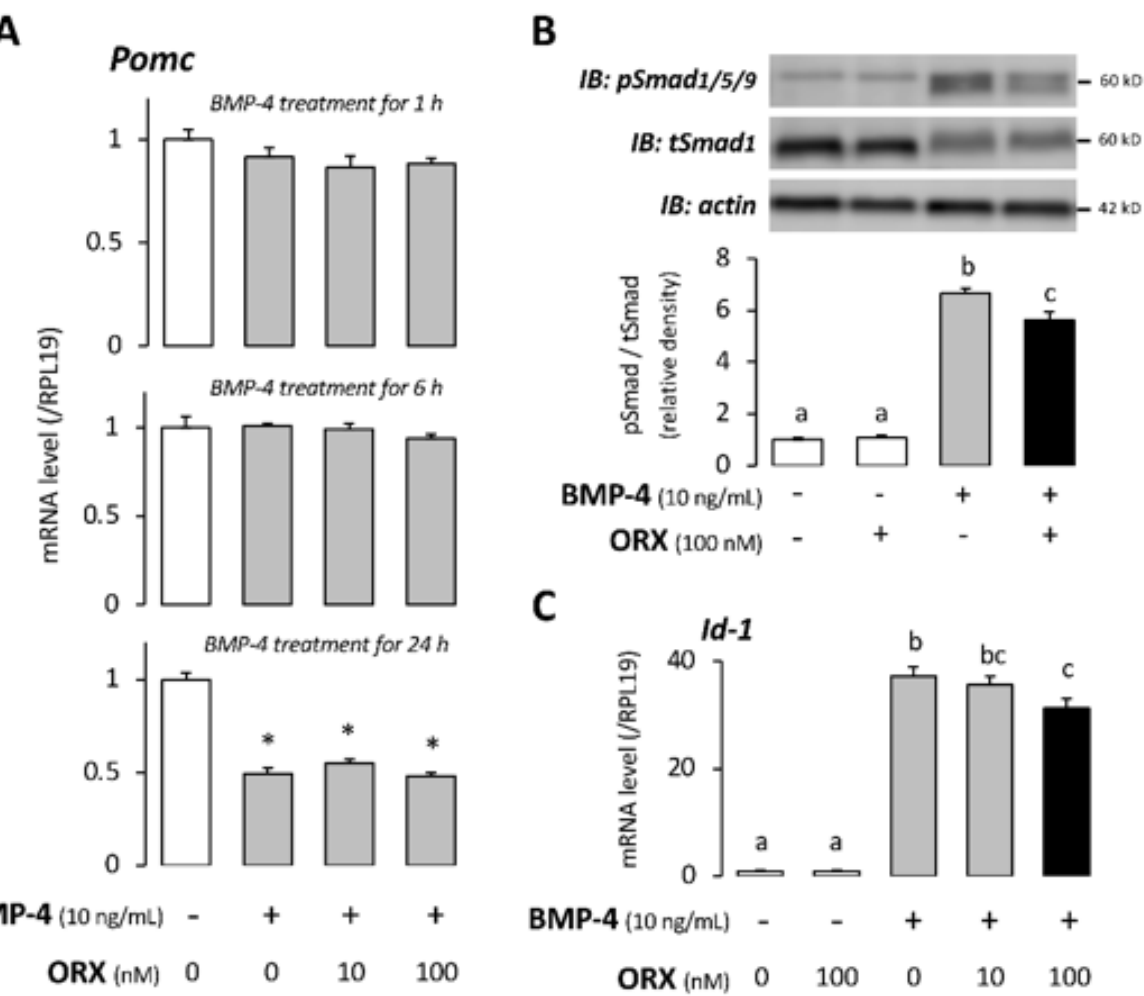
Figure 2. Effects of orexin A on BMP − receptor signaling in AtT20 cells. ( A ) After preculture, AtT20 cells were treated with the combination of orexin (ORX) and BMP − 4 in serum − free media. After 24 − h stimulation with orexin and 1 − , 6 − , and 24 − h stimulations with BMP − 4, total cellular RNA was extracted, and the mRNA expression levels of POMC were quantified by qPCR. The expression levels of target genes were standardized by the RPL19 level in each sample. ( B ) Cells were pretreated with ORX in serum − free media for 24 h. After 60-min stimulation with BMP − 4, the cell lysates were subjected to immunoblot (IB) analysis using anti − pSmad1/5/9, anti − tSmad1, and anti − actin. ( C ) Cells were pretreated with ORX in serum − free media for 24 h. After 60 − min stimulation with BMP − 4, total cellular RNA was extracted, and mRNA levels of Id − 1 were examined by qPCR. The expression levels of target genes were standardized by the RPL19 level in each sample. Results are shown as means ± SEM of data from at least three independent experiments. Statistical analysis was performed by ANOVA. Values with different superscript letters are significantly different at p < 0.05 ( B , C ). * p < 0.05 vs. between the control groups ( A ).